Question: What form of chart is displayed?
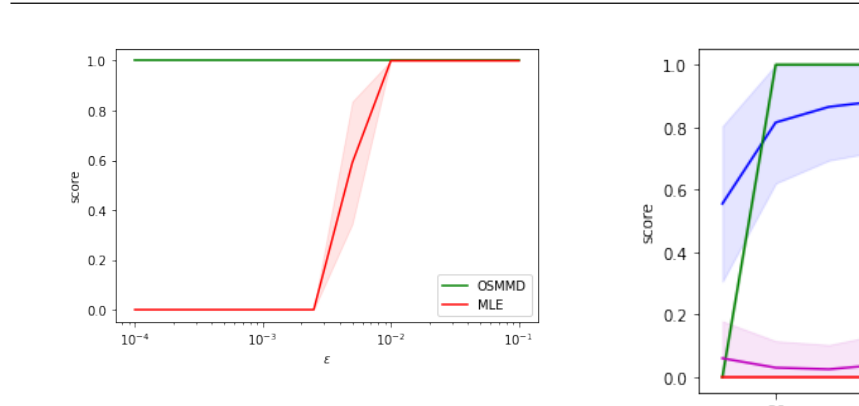
Answer: line